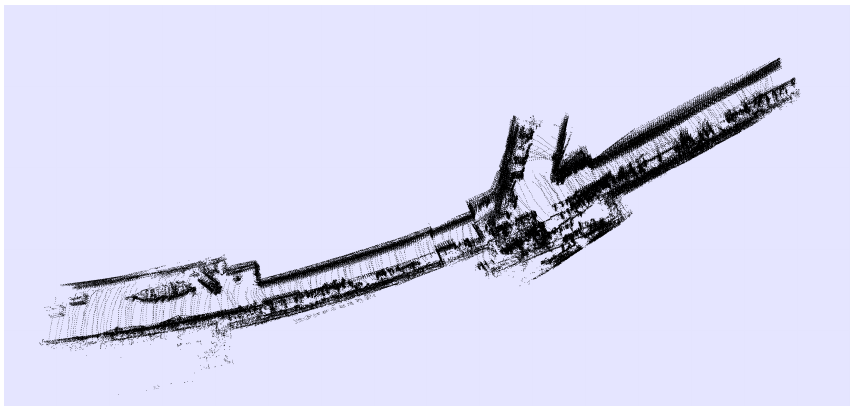
Figure 7. Reconstruction of the tunnel SPS during a survey. In this case, the area of test had many features to extract due to the lateral corridor and machines located in a wider area.